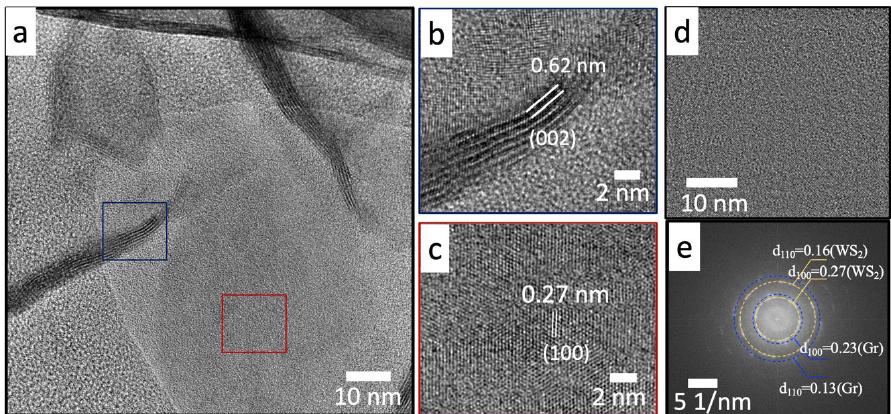
Figure 9. HRTEM images of graphene@WS 2 nanocomposites: ( a ) general view; ( b ) blue-box zoom-in, showing the crystal lattice of WS 2 d 002 ; ( c ) red-box zoom-in showing the crystal lattice of WS 2 d 100 ; ( d ) HRTEM image of interconnected graphene ws2 region and corresponding ( e ) FFT image.